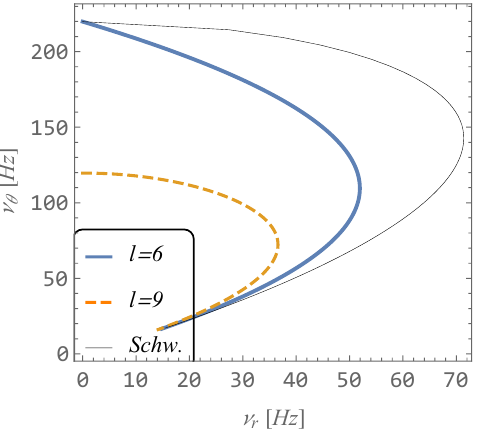
Figure 7. The dependence of ν θ on ν r for the values of the parameter l = { 0, 6, 9 } giving wormholes (except l = 0 corresponding to the Schwarzschild black hole); M = 10 M (cid:12)